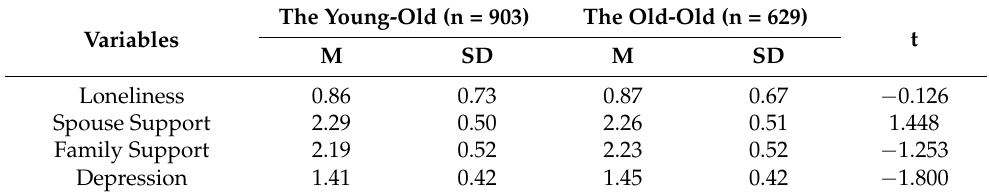
Table 2. Differences in Main Variables between the Young-Old and the Old-Old.